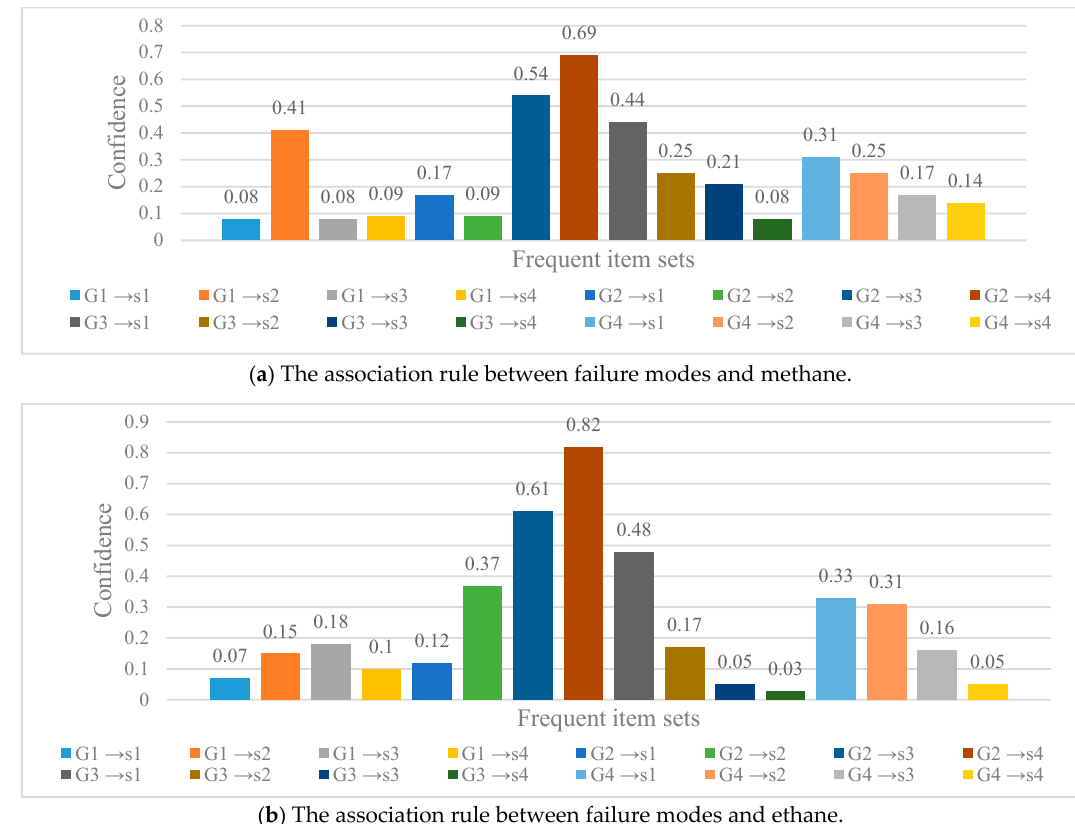
Figure 5. The calculation result.